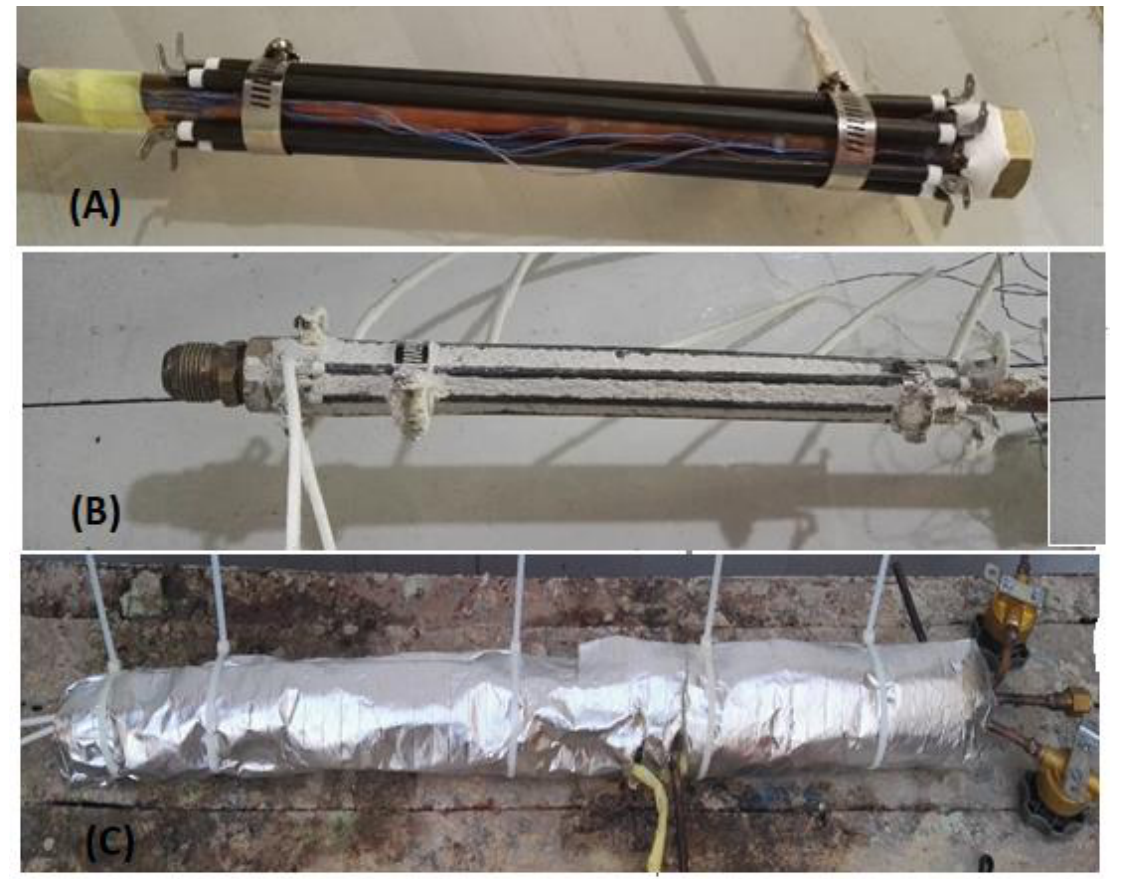
Figure 2. The evaporator heating system: ( A ) The evaporator section with the heaters. ( B ) Application of thermal clay between the heaters. ( C ) Application of thermal insulation glass wool and tape. Table 1. THP geometry and operating conditions.